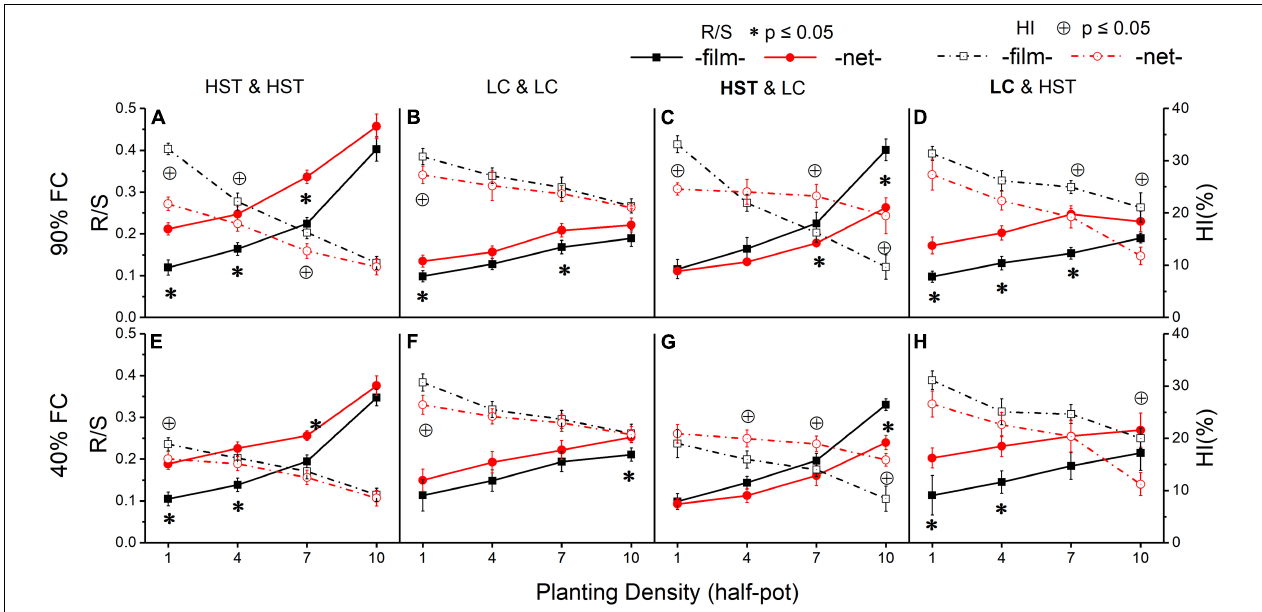
FIGURE 6 | Root to shoot ratio (R/S) and harvest index (HI) of two cultivars grown in the pots. Panels (A–D) are at 90% FC, panels (E–H) are at 40% FC. Panels (A,B,E,F) are HST and LC in monoculture; panels (C,D,F,G) are HST and LC in mixture. The cultivar in bold is the target in inter-cultivars treatment; “film” means separated by film; “net” means separated by net. All values are based on g dry mass per individual. The error bars indicate one standard error R/S and HI the mean. ∗ and L indicate significant differences in R/S and HI, respectively, between two soil divider